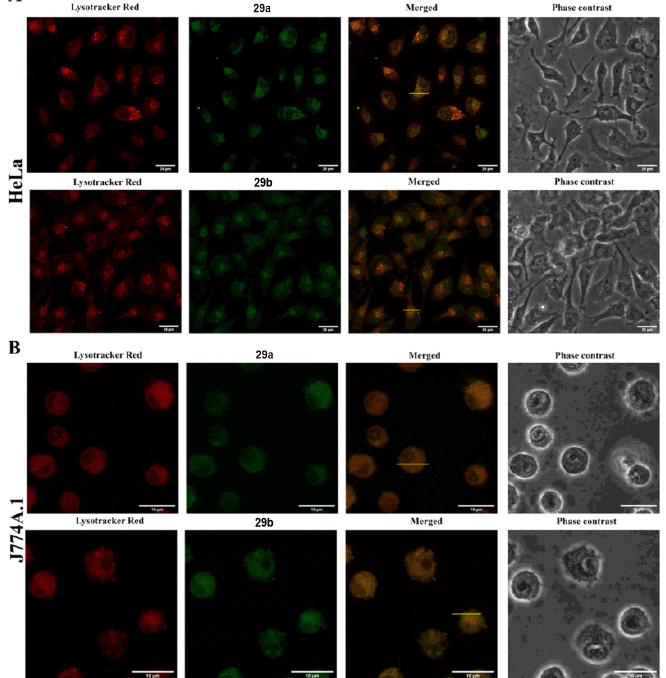
Figure 25. Confocal fluorescence images of ( A ) HeLa cells and ( B ) J774A.1 cells stained with LysoTracker Red and compounds 29a and 29b . Adapted from [68].